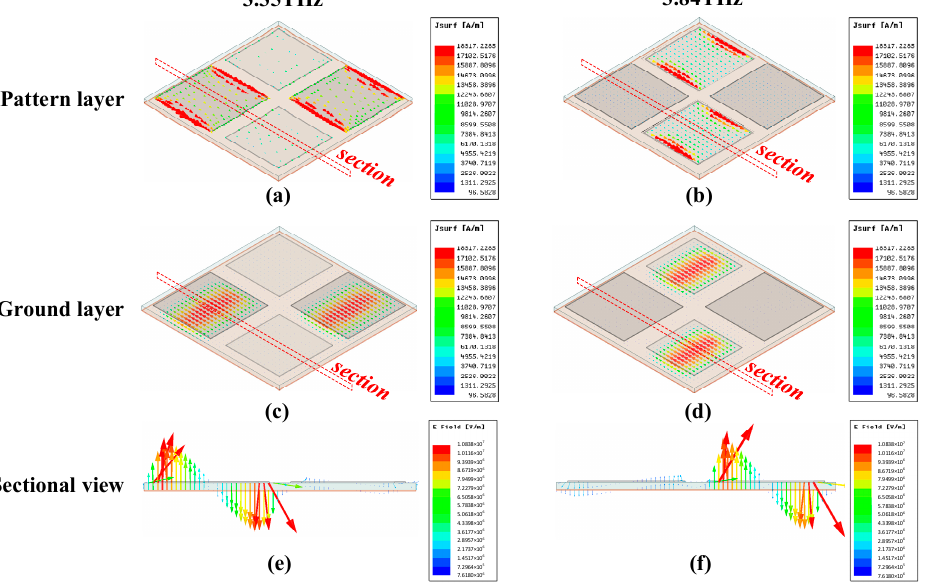
Figure 5. The surface current distributions in pattern layer at ( a ) 3.35 THz and ( b ) 3.84 THz, respec- tively. The surface current distributions in ground layer at ( c ) 3.35 THz and ( d ) 3.84 THz, respectively. The electric field vector in dielectric layer on the section at ( e ) 3.35 THz and ( f ) 3.84 THz, respectively.